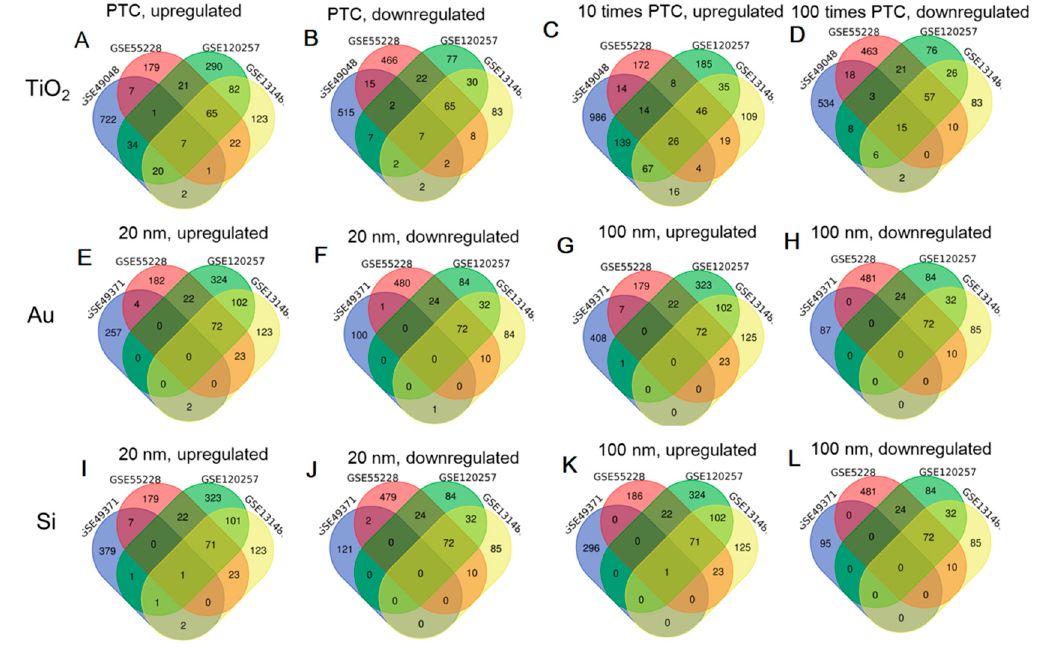
Figure 2. Venn diagrams to show the overlapped genes between NP exposure and ONC treatment. ( A ) overlapped upregulated genes between PTC TiO 2 NPs of GSE49048 and